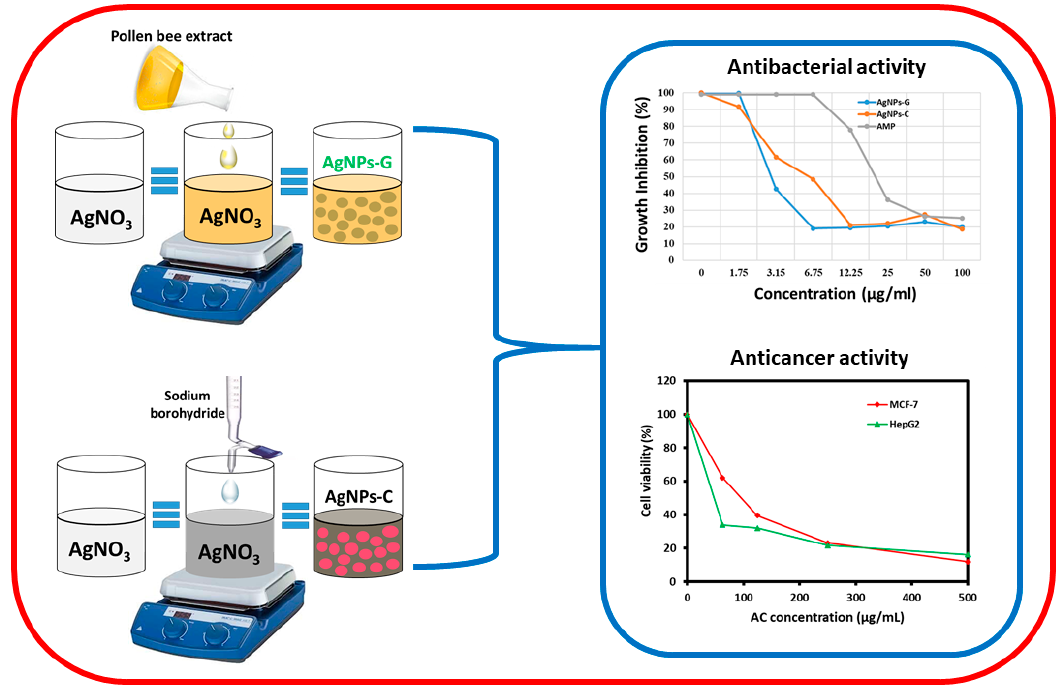
Figure 1. Graphical representation of green synthesized silver nanoparticles using pollen bee extract (AgNPs-G), chemical synthesized silver nanoparticles using sodium borohydride (AgNPs-C) and evaluation of their antibacterial and anticancer activity.